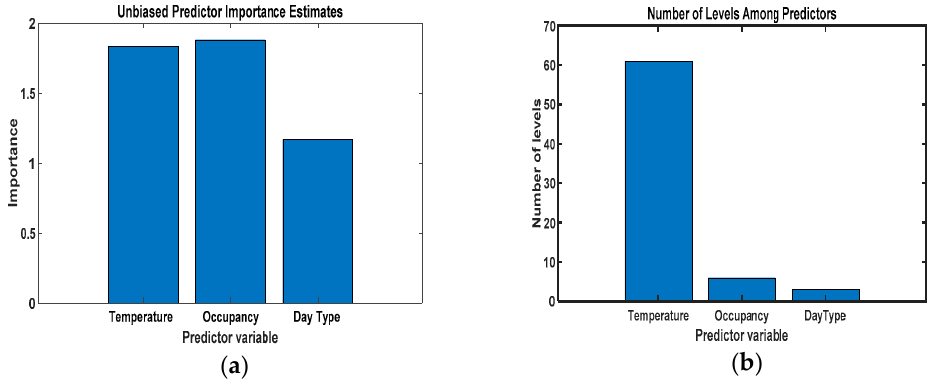
Figure 4. Random forest predictors’ ( a ) importance, and ( b ) number of levels.